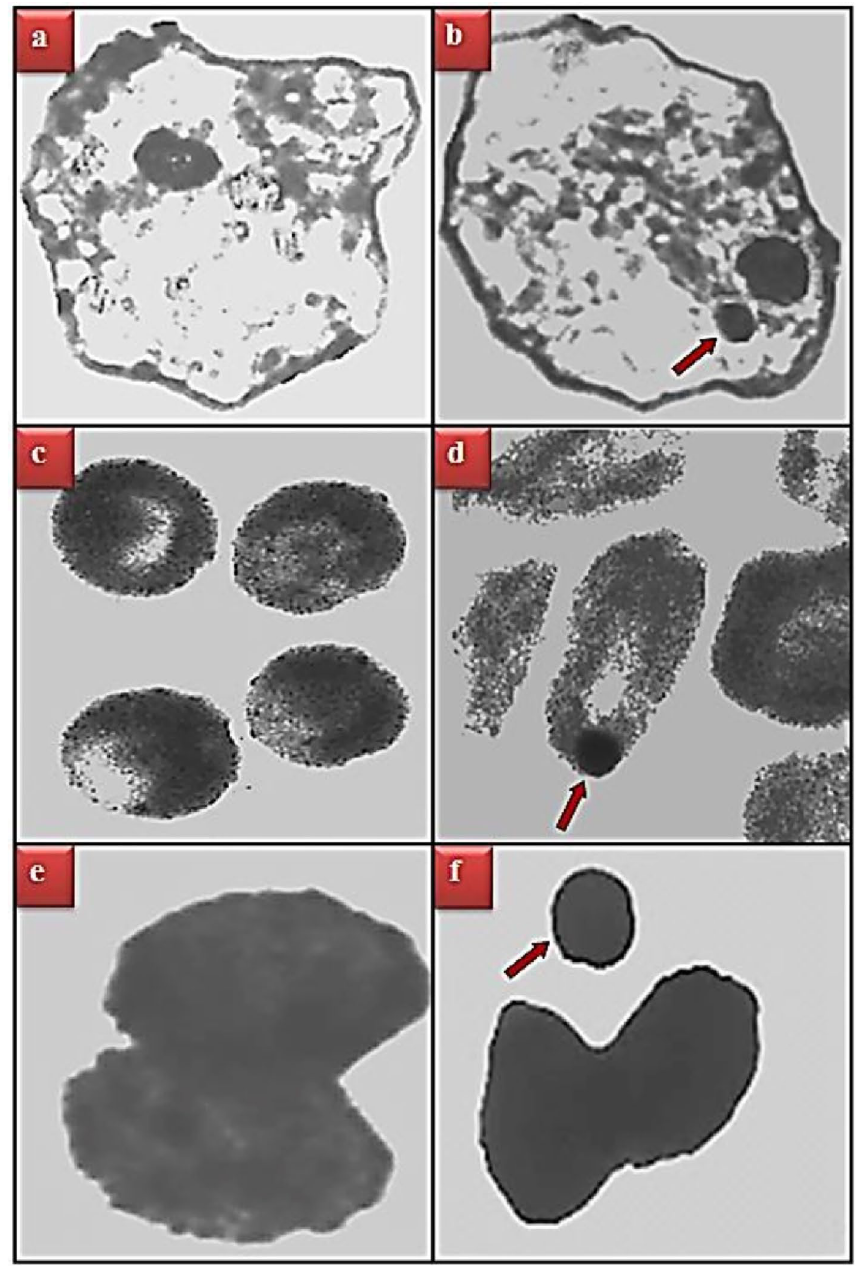
Figure 4. MN formation promoted by cypermethrin. Buccal mucosal epithelium normal appearance ( a ), buccal mucosal epithelium with MN ( b ), erythrocyte cell normal appearance ( c ), erythrocyte cell with MN ( d ), leukocyte cell normal appearance-basophil ( e ), leukocyte cell-basophil with MN ( f